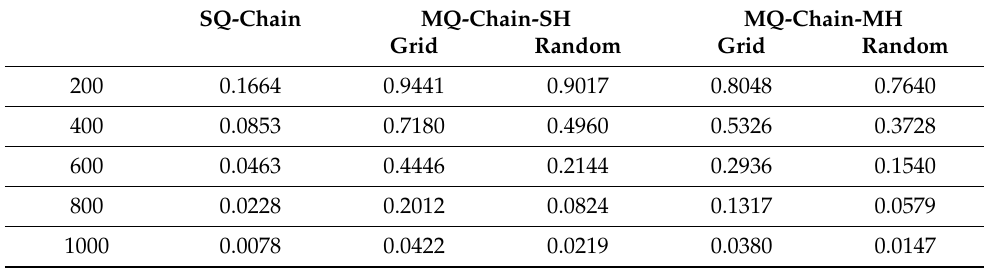
Table 3. Comparison of Q-Chain